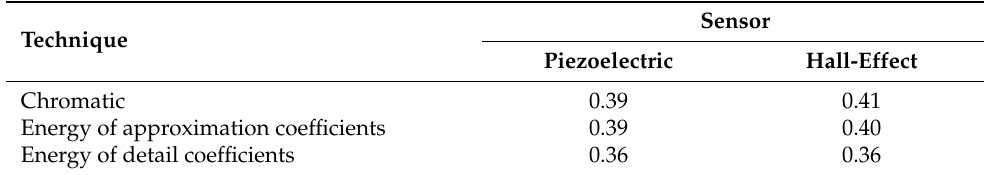
Table 1. Normalized Euclidean distances for each